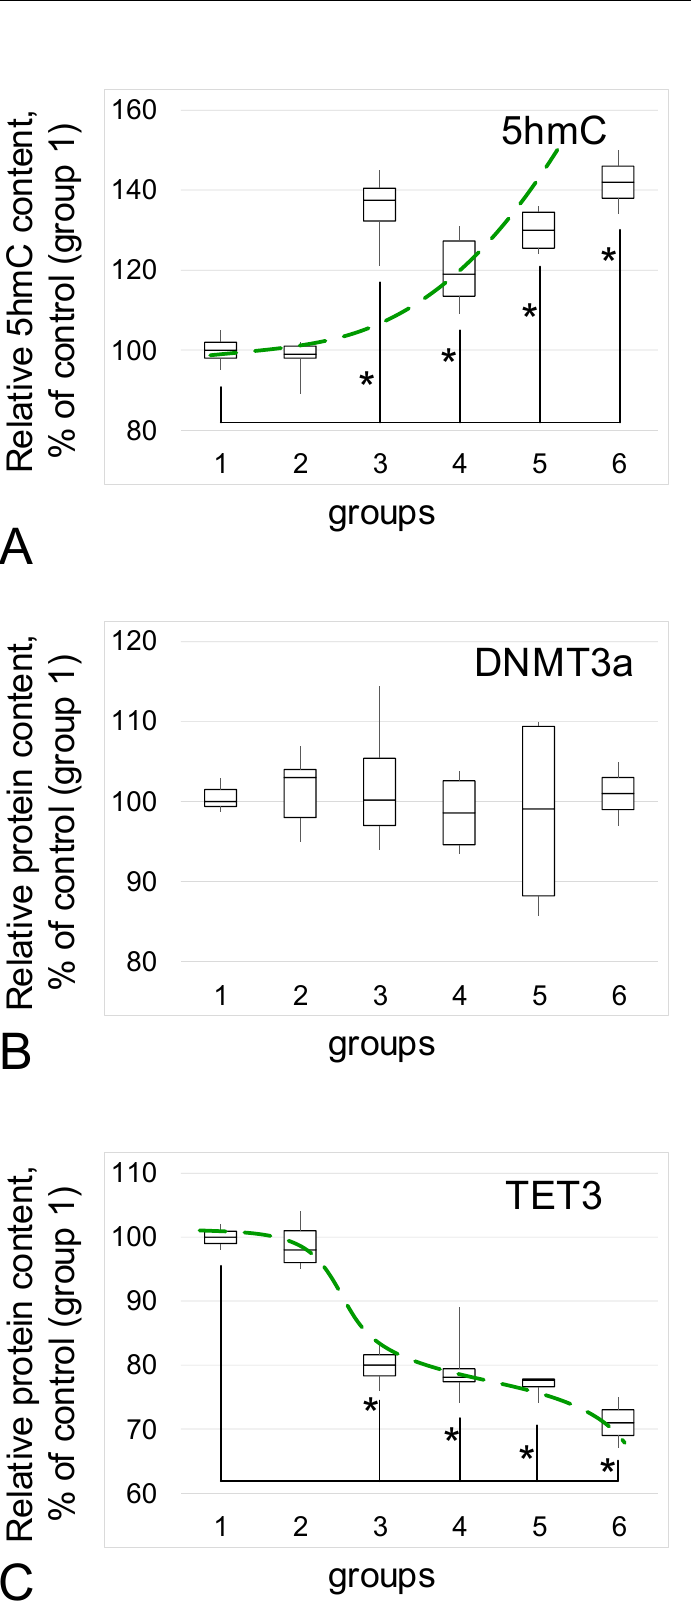
Figure 6. Relative content of 5-hydroxymethylcytosine (5hmC) and methylase/demethylase proteins. ( A )—5hmC. ( B )—Methylase DNMT3a relative content. ( C )—Demethylase TET3 relative content. *— p < 0.05 in comparison with control group 1 (women in postmenopause without endometriosis in their anamnesis). Green dash line reflects trends. Group designations are the same as above.